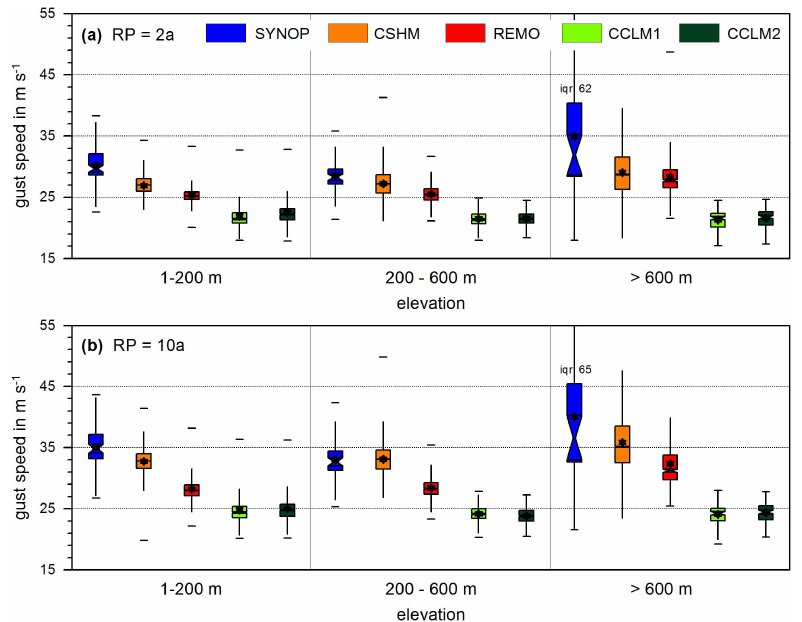
Fig. 8. Distribution of gust wind speed for a 2-year (a) and 10-year (b) return period from observations and different RCMs for three height intervals. Indicated are maximum and minimum values, median and mean (star), 25th and 75th percentiles (box), and 1.5 · interquartile range (iqr; vertical